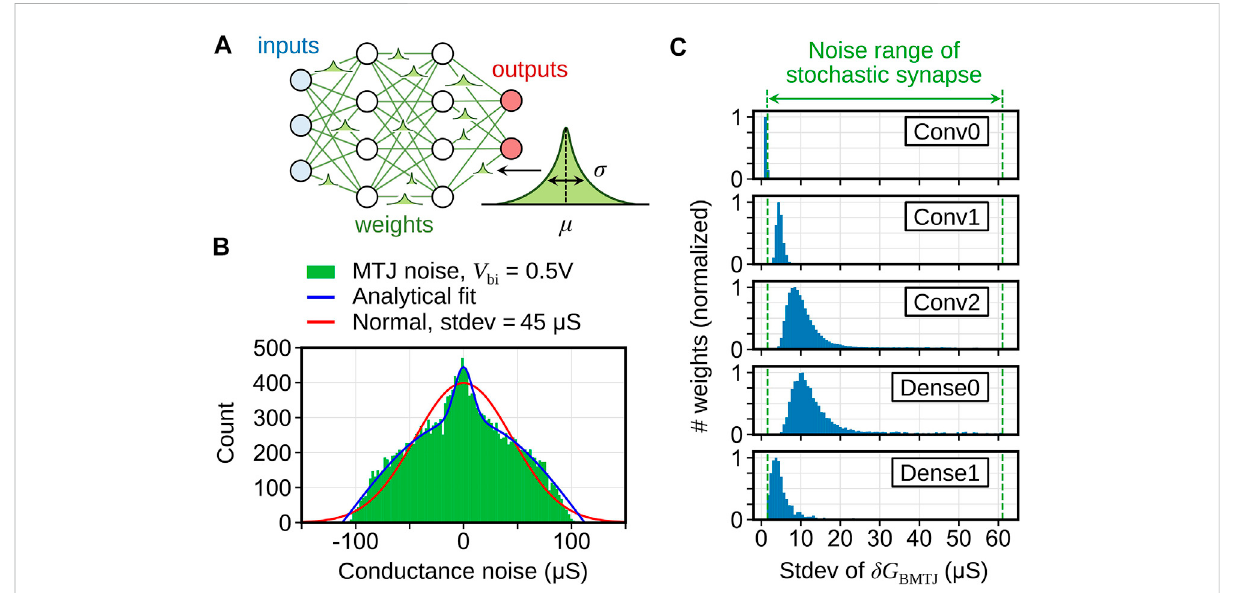
FIGURE 3 (A) Schematic of a Bayesian neural network where each weight follows a Gaussian distribution N ( μ , σ ) , (B) Analytical fi t to the BayesMTJ noise distribution from LLG simulations, and Gaussian distribution with the same standard deviation, (C) Distribution of σ values for each layer of a